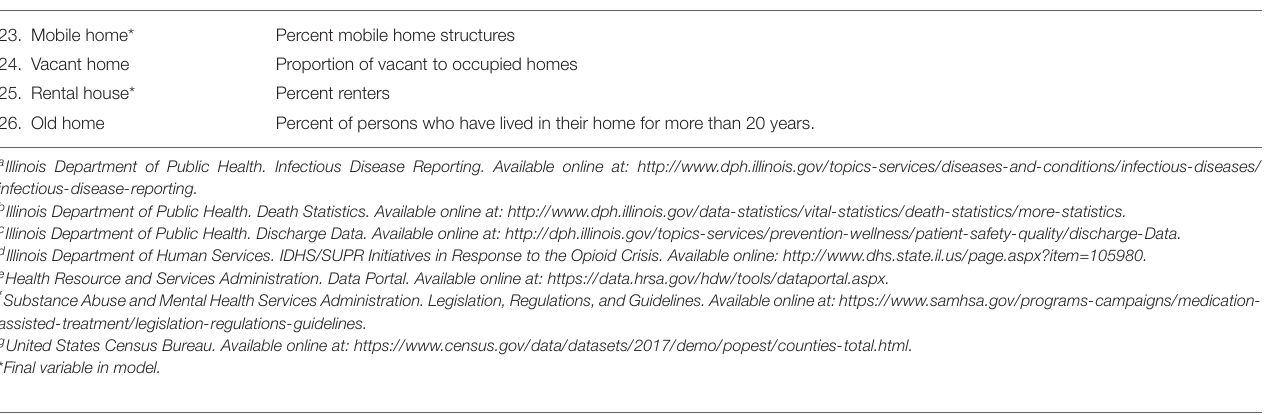
TABLE 2 | Negative binomial regression results for final model with significant